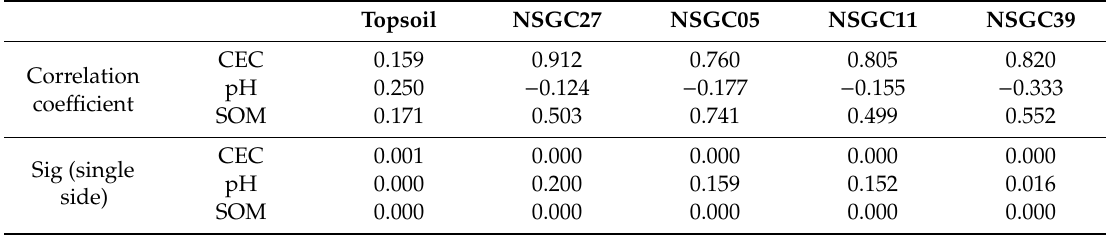
Table 4. Correlation and significance of cadmium concentration with cation exchange capacity (CEC), pH, and soil organic matter (SOM) in topsoil and four di ff erent cores.